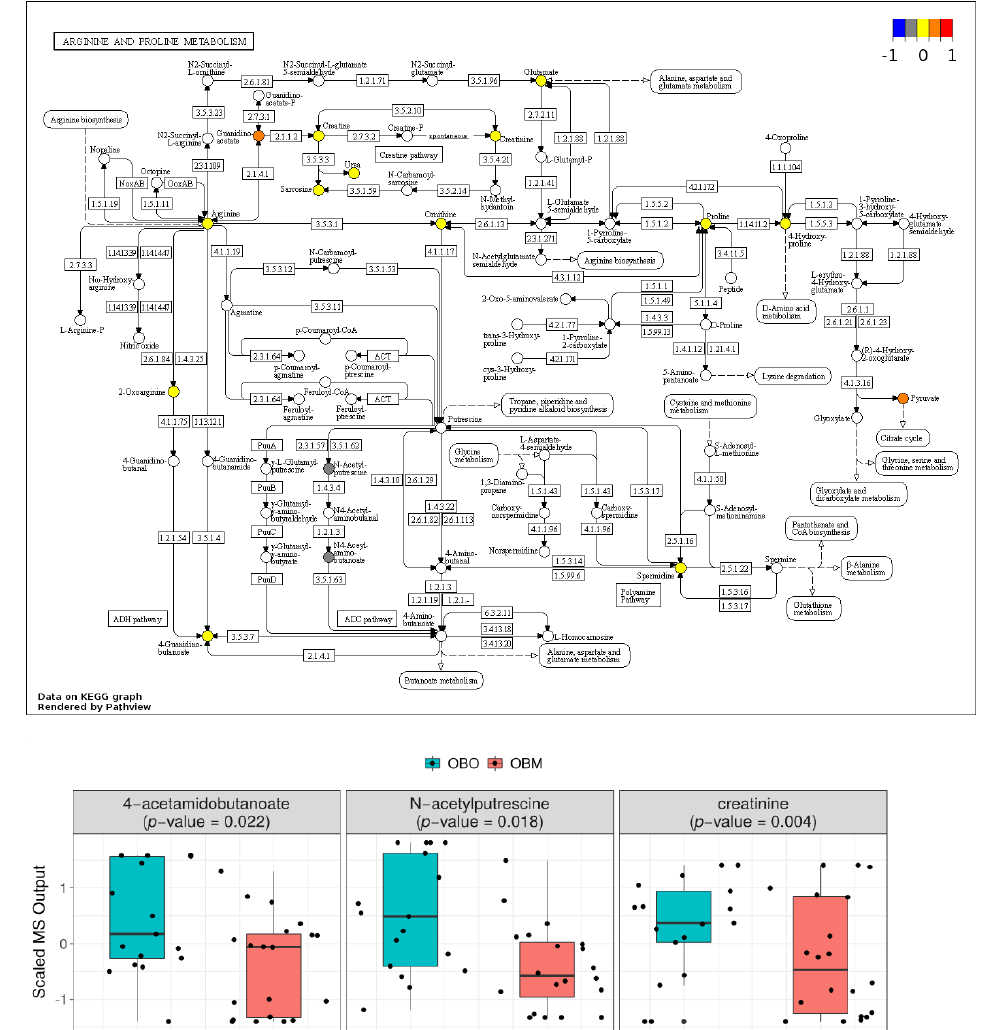
Figure 4 Figure 4. KEGG pathway map of arginine and proline metabolism. Metabolites in blue, yellow, and red have lower, the same, and higher concentrations, respectively, in OBM compared to OBO. Non-colored metabolites were not part of the metabolomics profile. The box plots show distribution of significant metabolites ( p < 0.05) in the pathway. The box plots are supplemented with violin plots to show distribution of samples across different